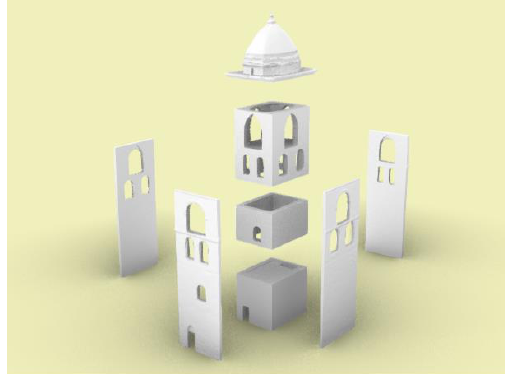
Figure 4. Model subdivision in Rhinoceros